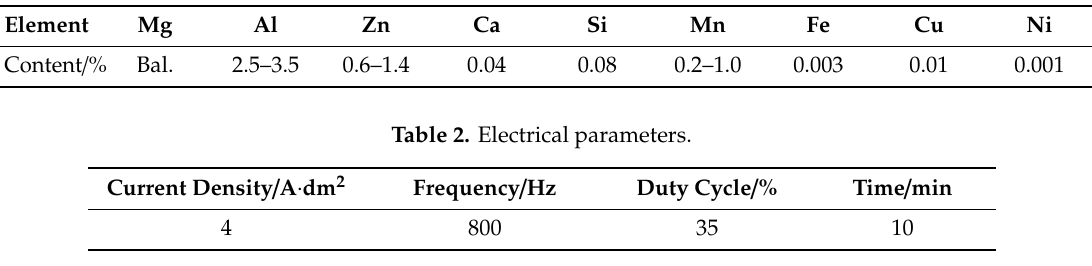
Table 1. Composition of AZ31 Mg alloy.